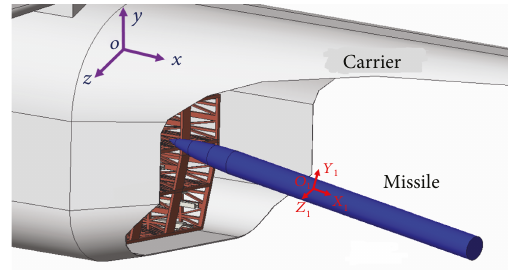
Figure 1: Coordinate system de fi nition diagram.